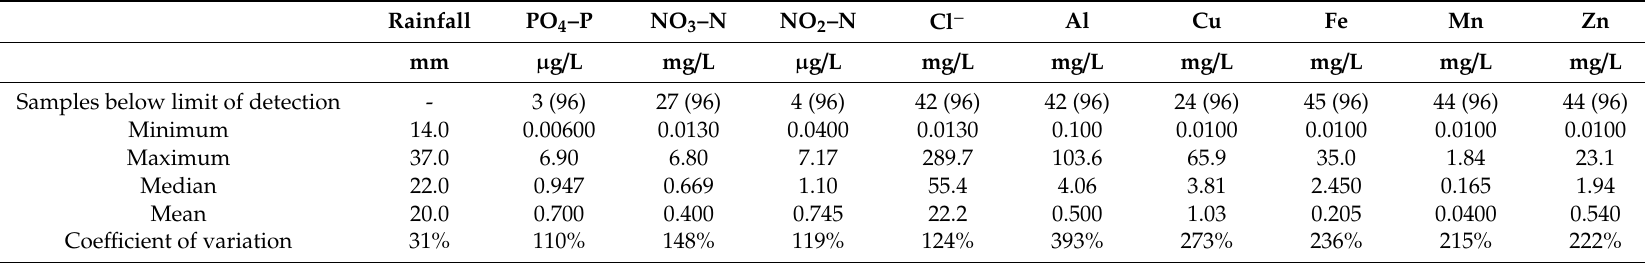
Table 2. Summary for dissolved nutrient and metal concentrations measured in infiltrated water in roadside ditches on State Route 34 in Pierre, South Dakota, United States. Numbers in parentheses represent the total samples collected. Water samples were collected for major rainfall events between May 2016 and October